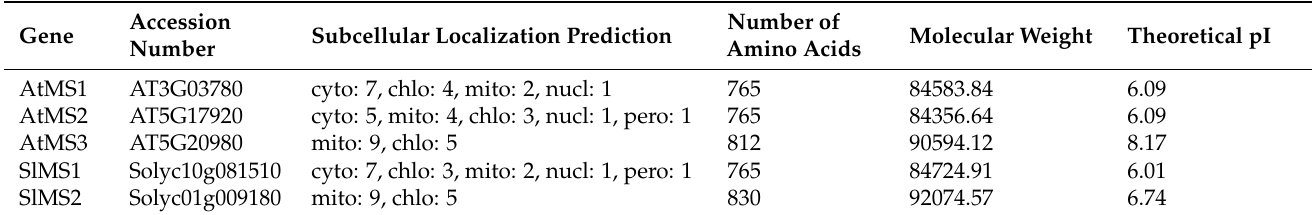
Table 1. Nuclear localization prediction and physicochemical analysis of methionine synthases in A. thaliana and tomato.